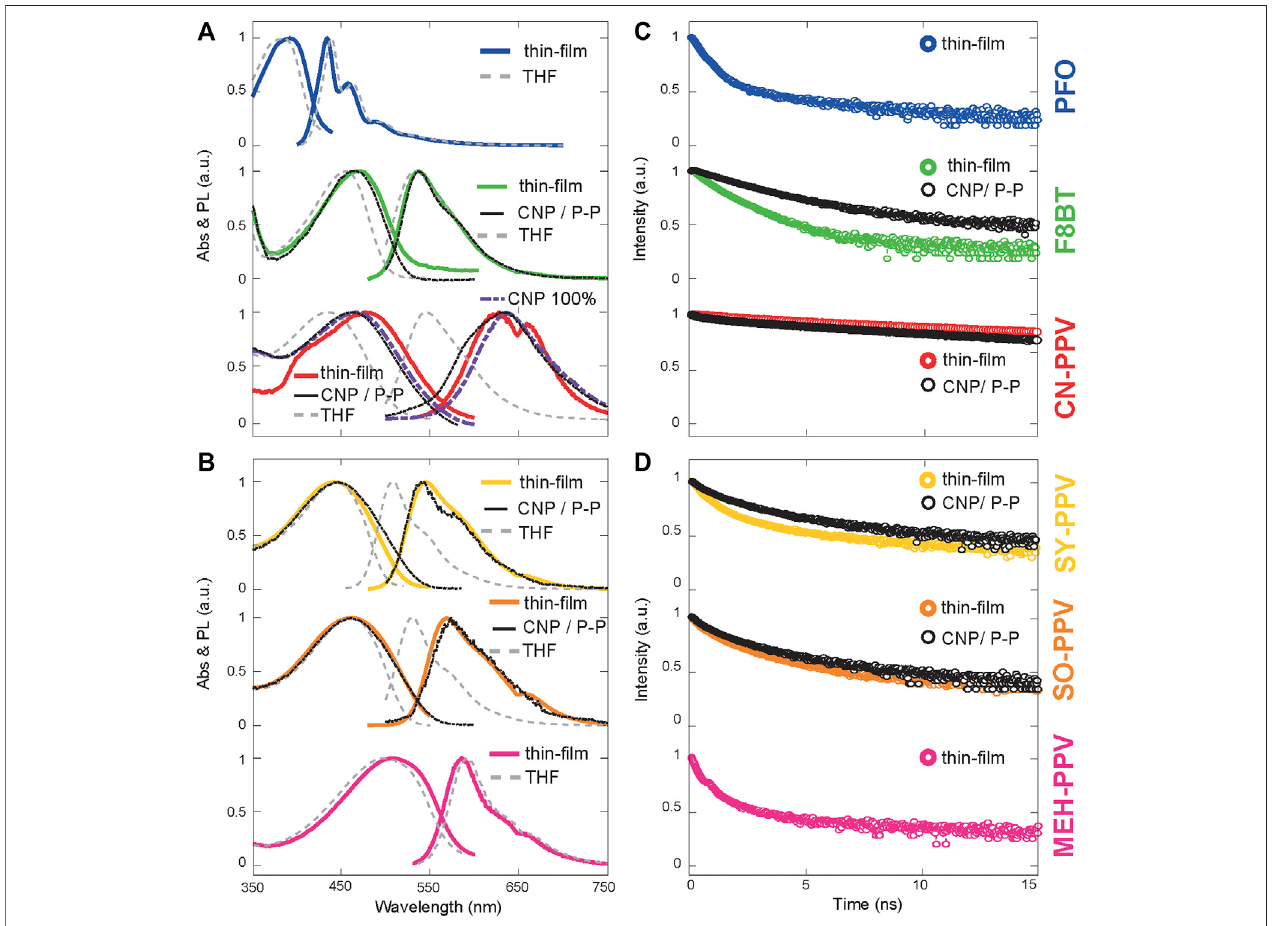
FIGURE 2 | Photophysical characterization of OSC thin fi lms and CNPs. (A,B) Optical absorption (Abs) and photoluminescence (PL) spectra and (C,D) photoluminescence decay lifetimeof the sixconjugated polymers in solid-state thin fi lmsand CNPs in DI-water. The spectra of the polymers in THF are also reported for